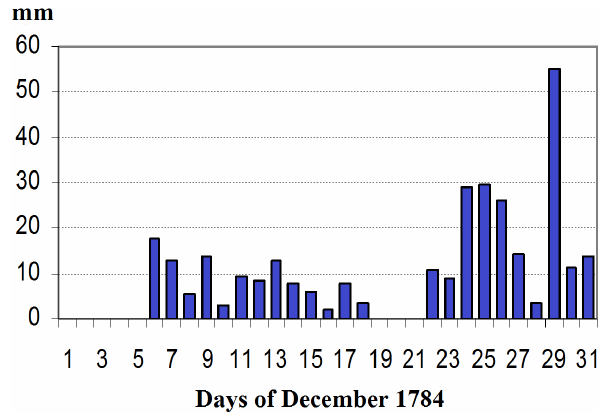
Fig. 8. Daily rainfall amounts in Mafra in December Figure 8. Daily rainfall amounts in Mafra in December 1784.